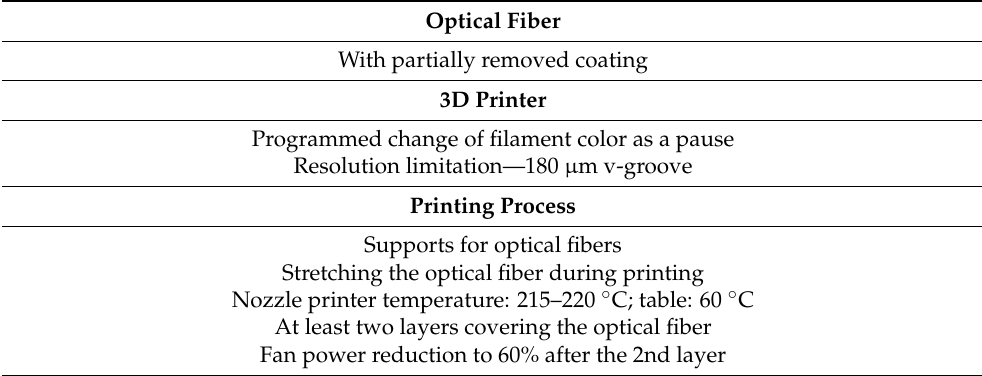
Table 1. Three-dimensional printing main